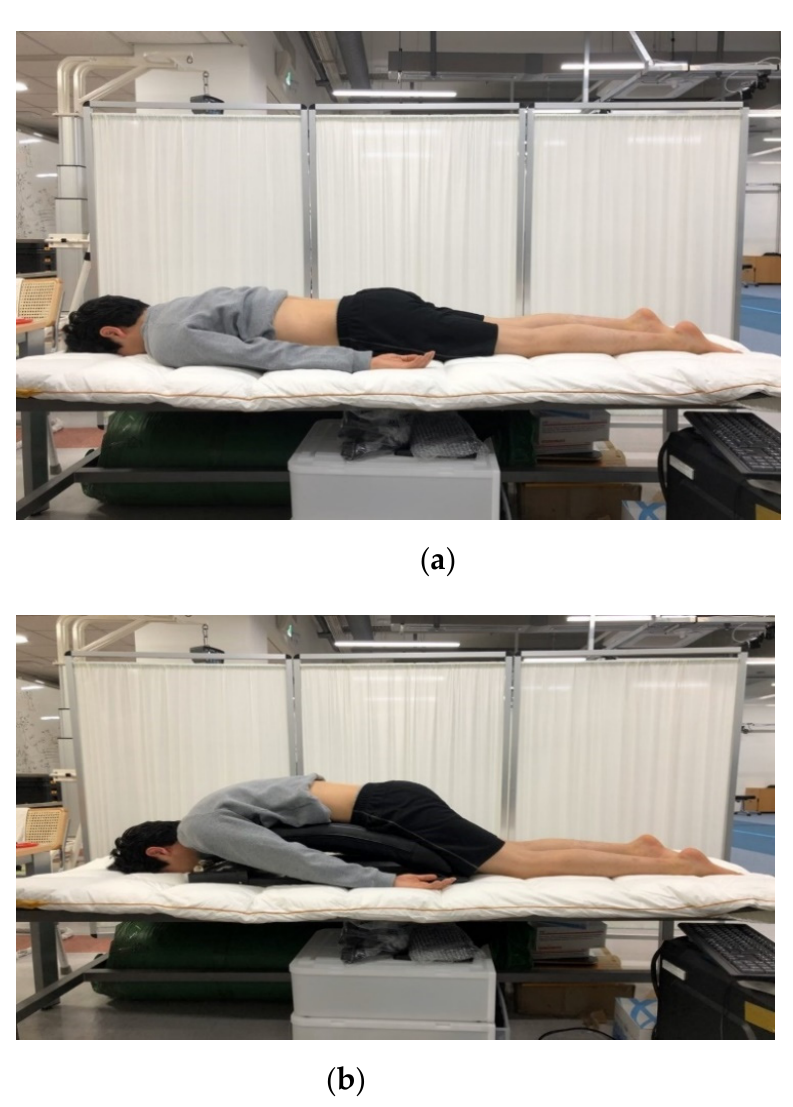
Figure 2. Two different prone postures on (a) flat table and (b) Wilson table. Each shear elastic modulus of the aforementioned muscles was evaluated by measuring shear ‐ wave propagation speed in the tissue, which was generated using SWE at each measurement posture. The circular regions of interest (ROIs) were set in the color ‐ coded boxes on the SWE mode (Figure 3). Three circular ROIs with a diameter of 10 mm were set in the color ‐ coded box, with one located at the top–center of the box and the other two located at the inferior to the first ‐ assigned circular ROI (Figure 3) [21,24]. Shear elastic modulus at the set ROI was automatically calculated from the ultrasound imaging device. The mean shear ‐ elastic ‐ modulus values of the three circular ROIs were calculated for each muscle per posture for five images. ROIs were determined by the same examiner.